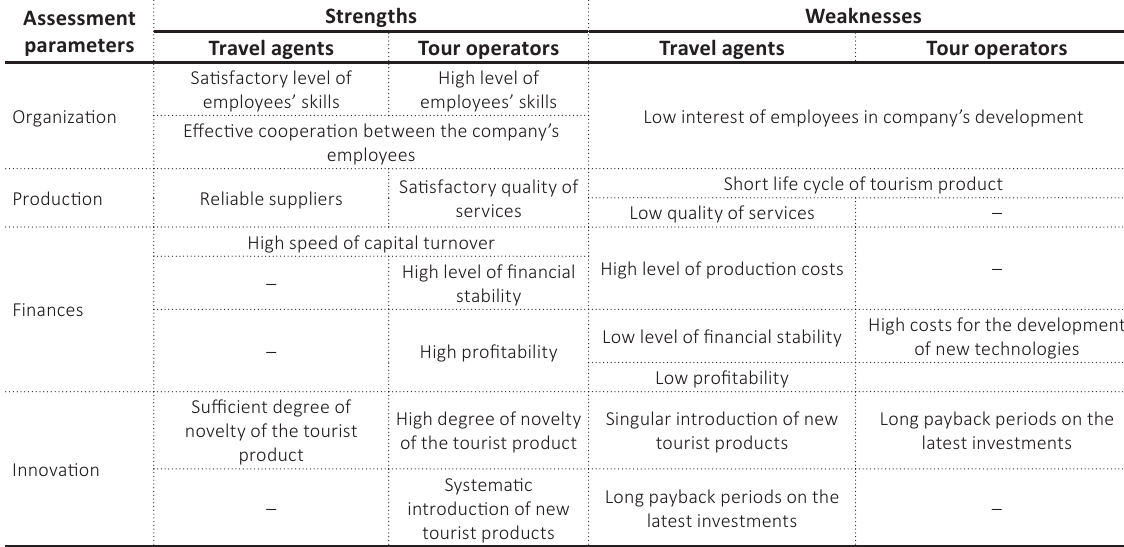
Table 6. Strengths and weaknesses of major tourism infrastructure companies